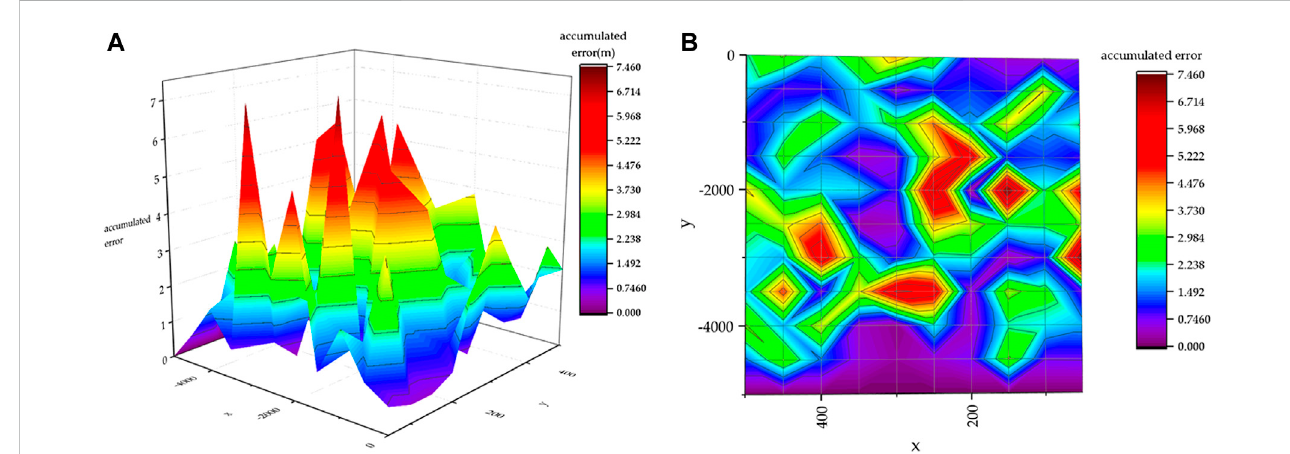
FIGURE 7 Schematic diagram of the change of the target location fusion error σ with the change of XY coordinates of the target. (A) 3D-view. (B) xoy projection